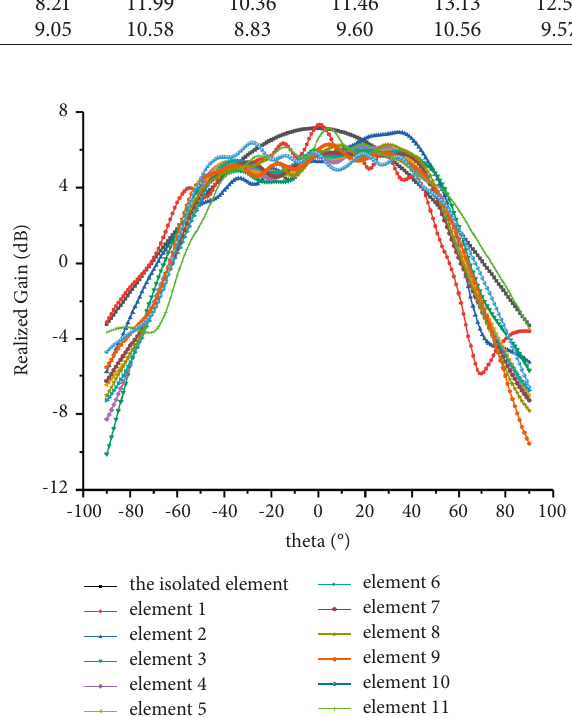
Figure 10: The active element patterns of all